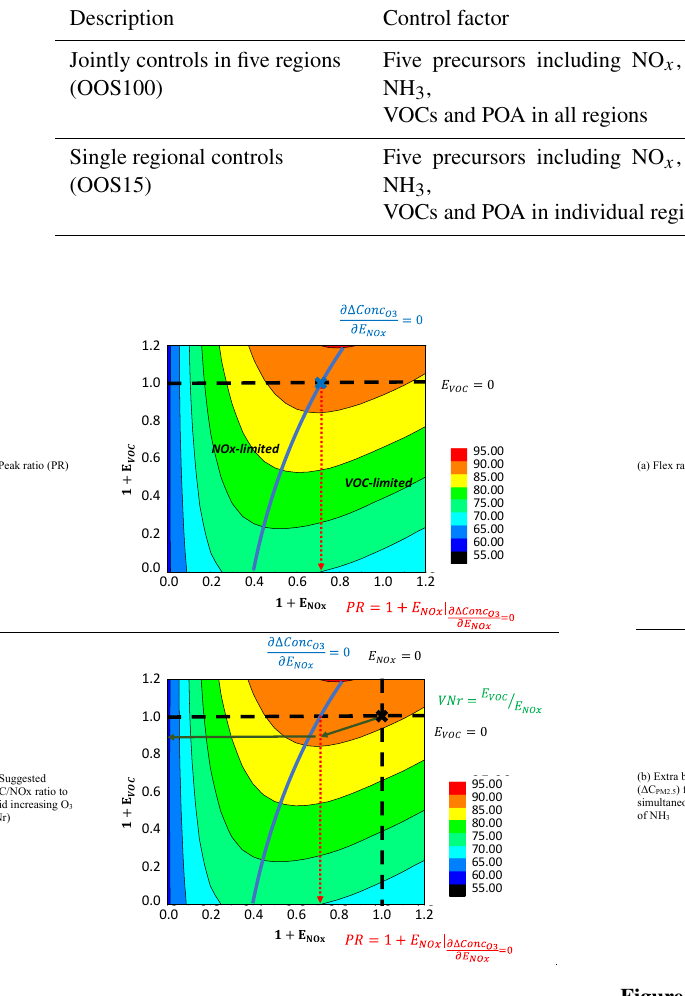
Figure 6. Definition of flex ratio (FR) and extra benefit from si- multaneous reduction of NH 3 basing on the 2-D isopleths of PM 2 . 5 sensitivity to NO x and NH 3 emission changes (an example in Bei- jing in